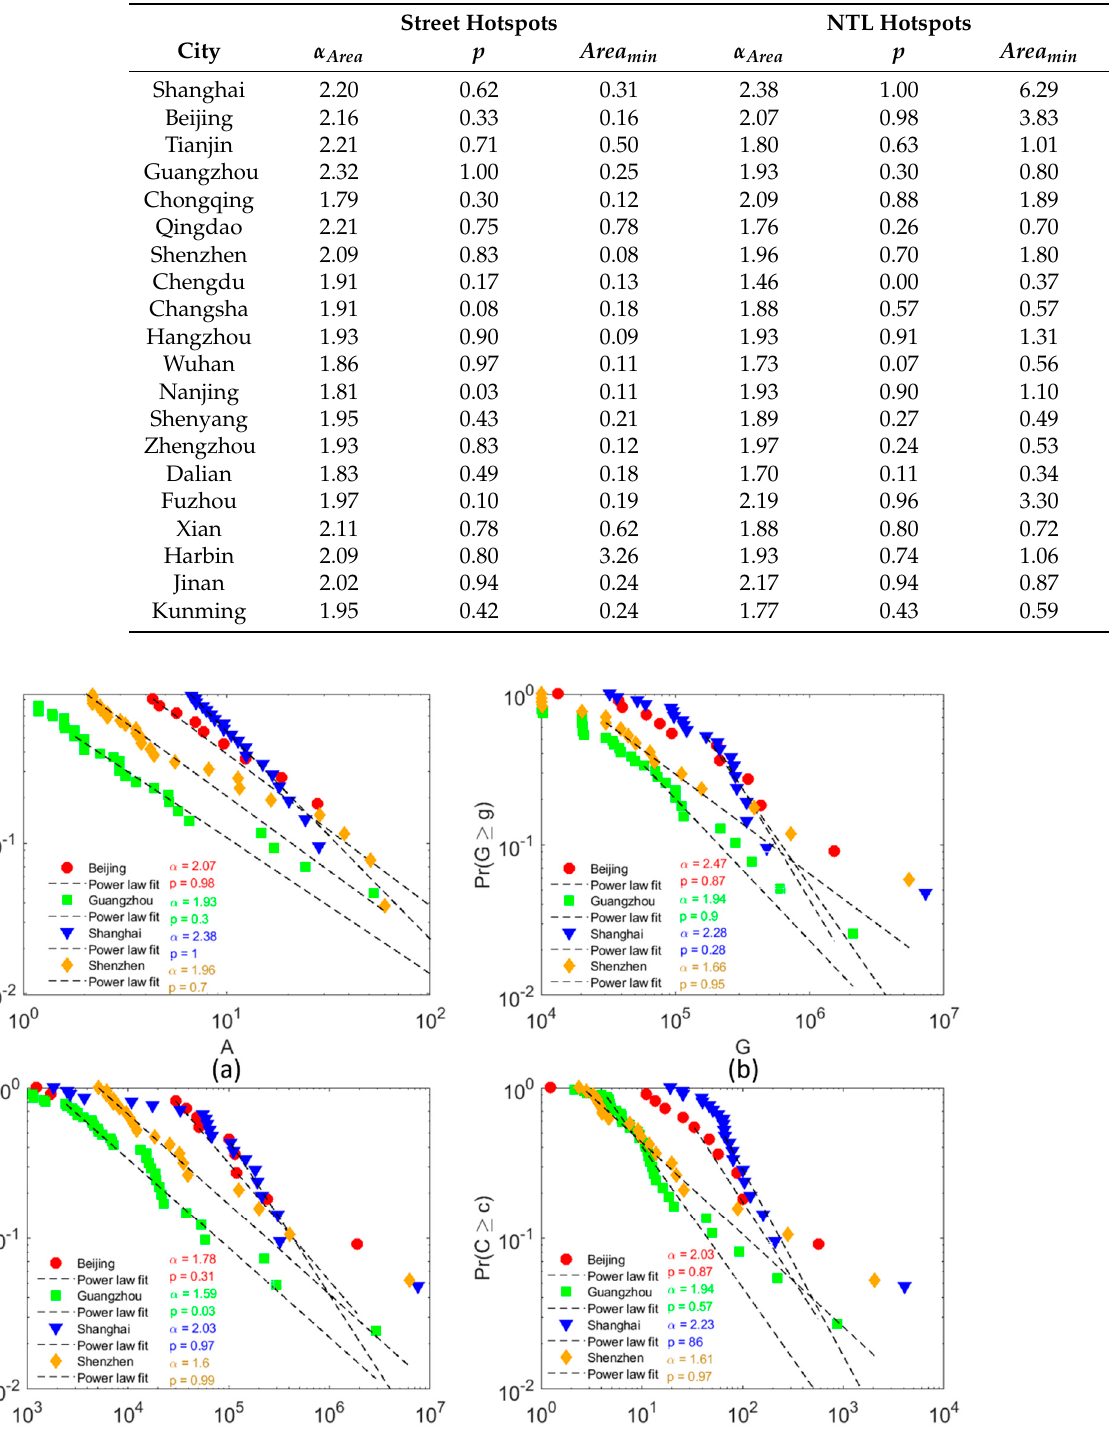
Table 3. Power law metrics of detected urban hotspot areas. (Note: α Area : Power-law exponent; p : The goodness-of-fit index; Area min : The minimum area above which the power-law holds).